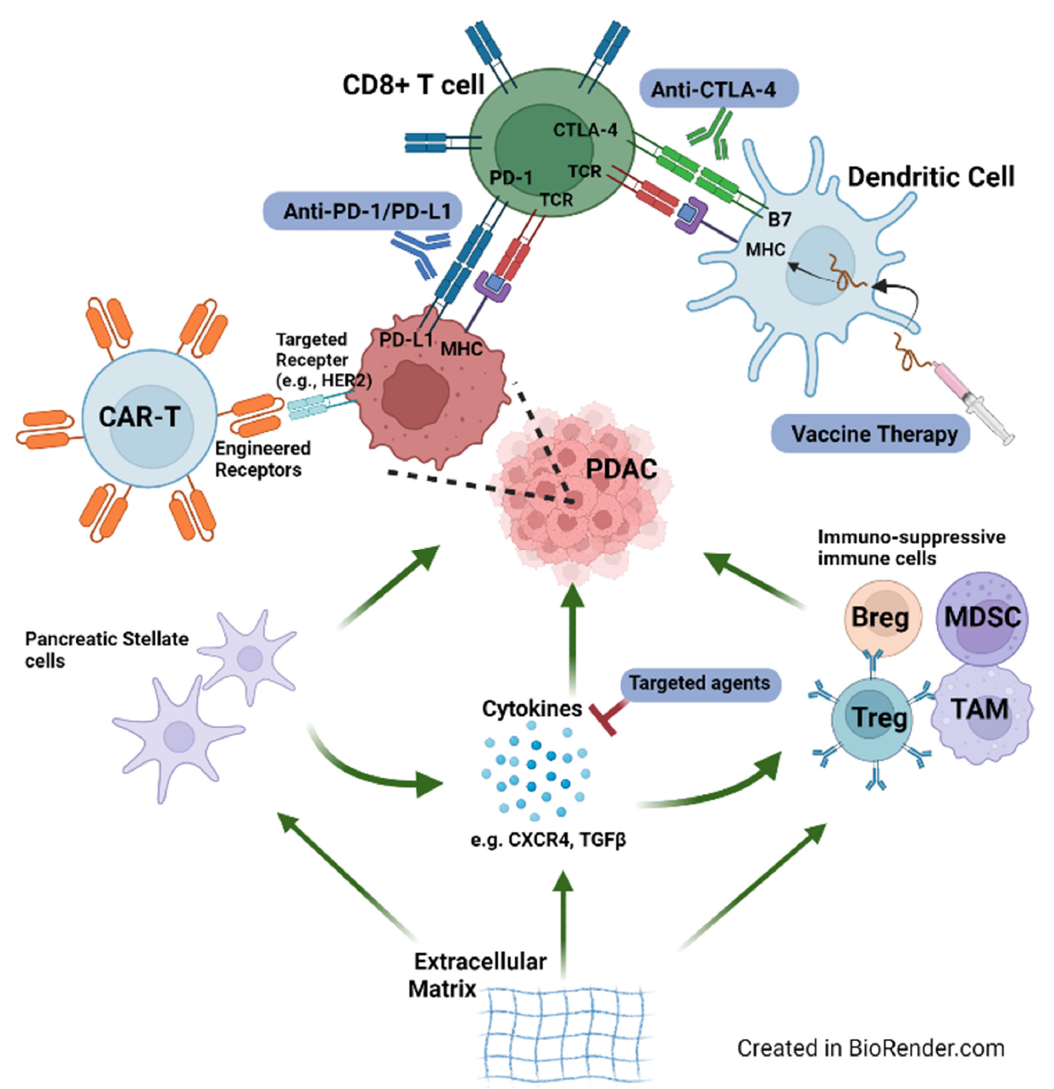
Figure 1. Graphical representation of the immune microenvironment for PDAC. Factors promoting tumoral growth (e.g., pancreatic stellate cells) are indicated with green arrows. Select immunotherapies and targeted therapies are also represented in the figure. Indeed, PDAC is characterized as a “cold tumor” due to its paucity of intra-tumoral CD8+ T cells in both human tumor samples and mouse models [55,56]. PDAC cells also